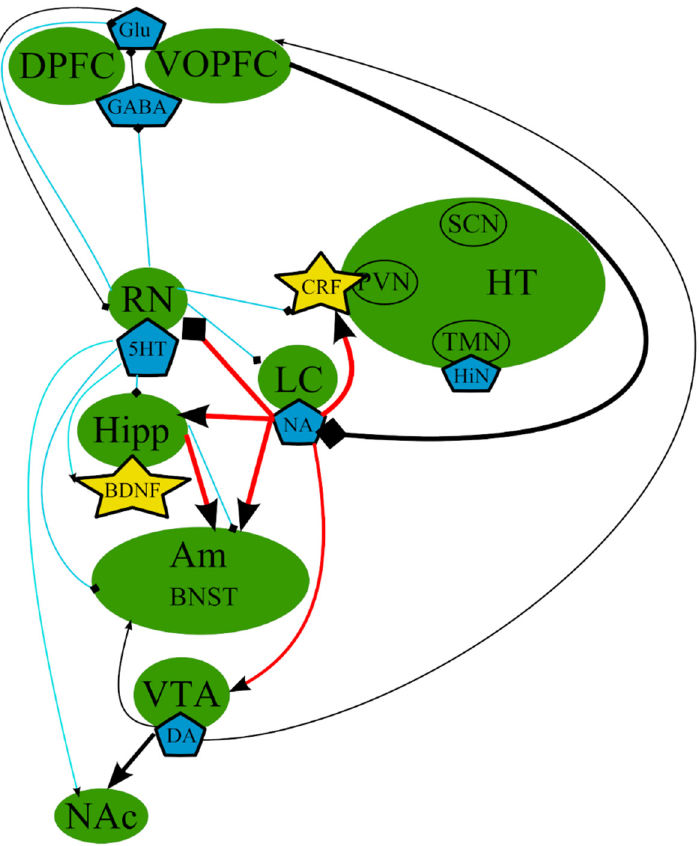
Figure 1. The monoamine hypothesis: main brain structures, neurotransmitters, biologically active substances, and interactions. BDNF—brain-derived neurotrophic factor; BNST—bed nuclei stria terminalis; CRF—corticotropin-releasing factor; DA—dopamine; DPFC—dorsal prefrontal cortex; Glu—glutamine; GABA—gamma-aminobutyric acid; HiN—histamine; Hipp—hippocampus;